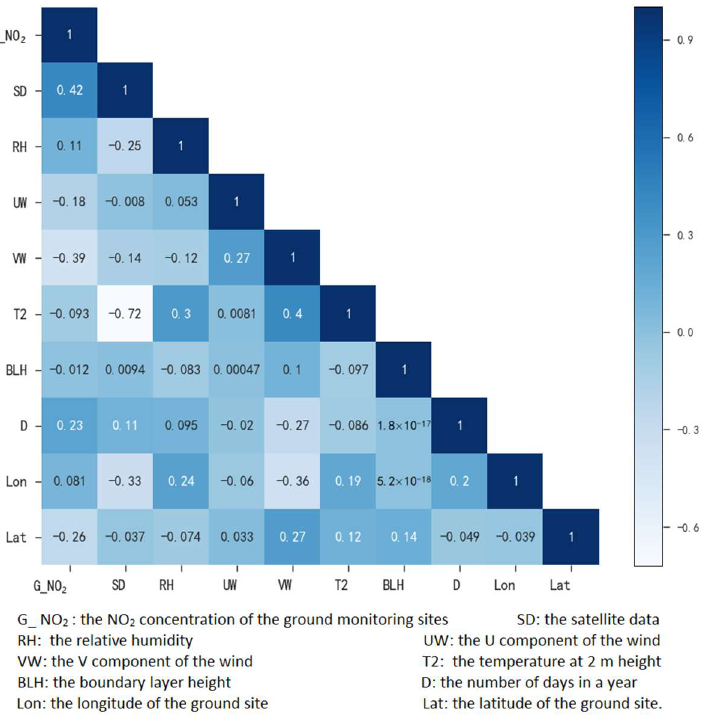
Figure 6. Distribution of correlation coefficients (CCs) between explanatory variables and dependent variables.